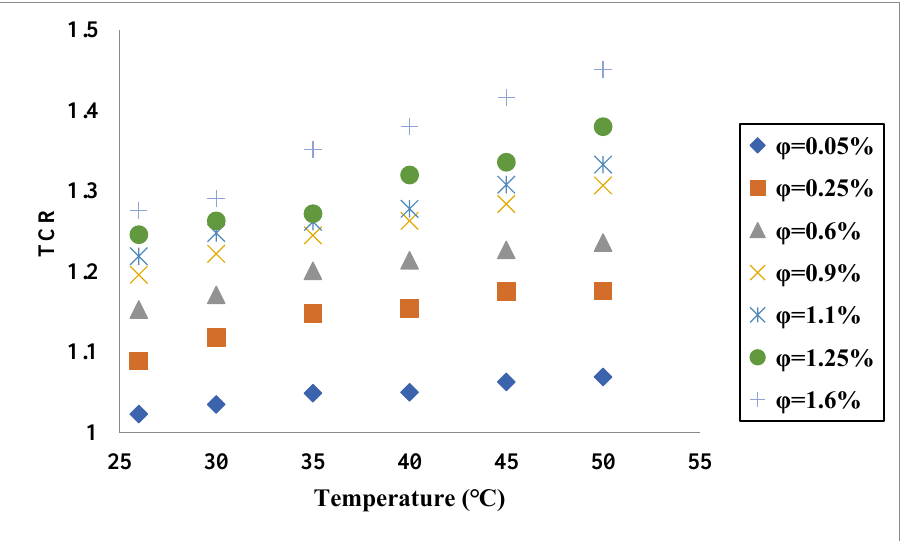
Figure 4. Influences of temperature and VF on TCR of SWCNT-ZnO/EG-water. Adapted from Ref. [49].